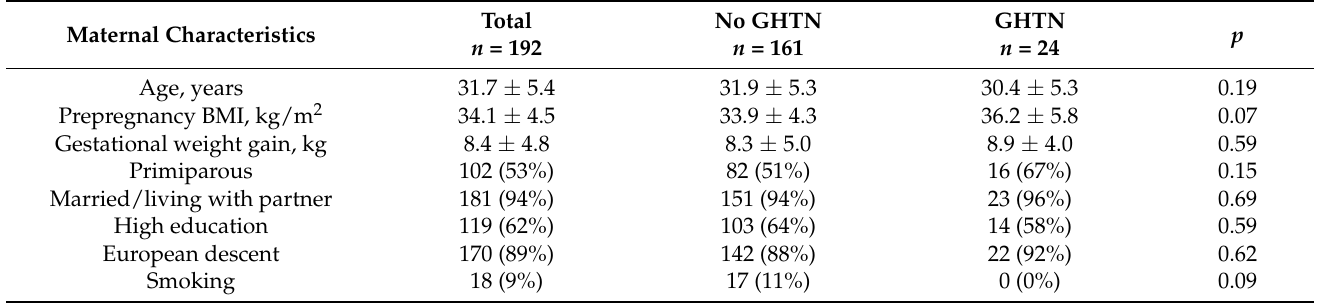
Table 1. Characteristics of study